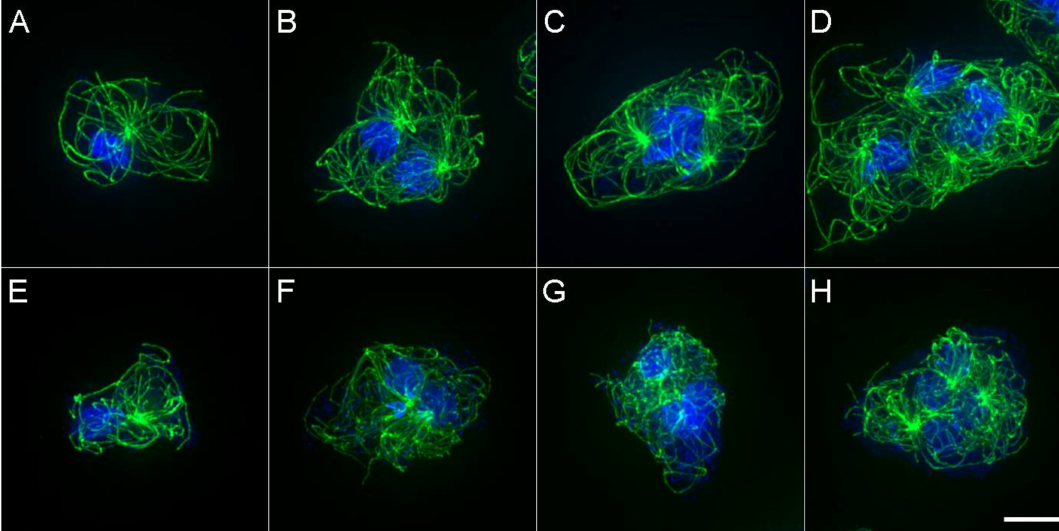
Figure 4. MT arrays in wild type and Ase1A null cells. Panels ( A – D ) show wild-type MT arrays in mono-, bi-, tri- and tetra-nucleated cells. Panels ( E – H ) show similar views of Ase1A null cells. Note in panels ( F – H ), the centrosomes are closer together and MT patterns are less distinct. Scale bar = 5 µ